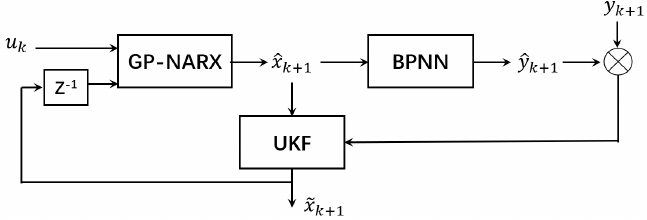
Figure 4. Joint angle prediction from the muscle activation and interactive force where (cid:101) x k + 1 represents the estimated value of x k + 1 calculated by the UKF